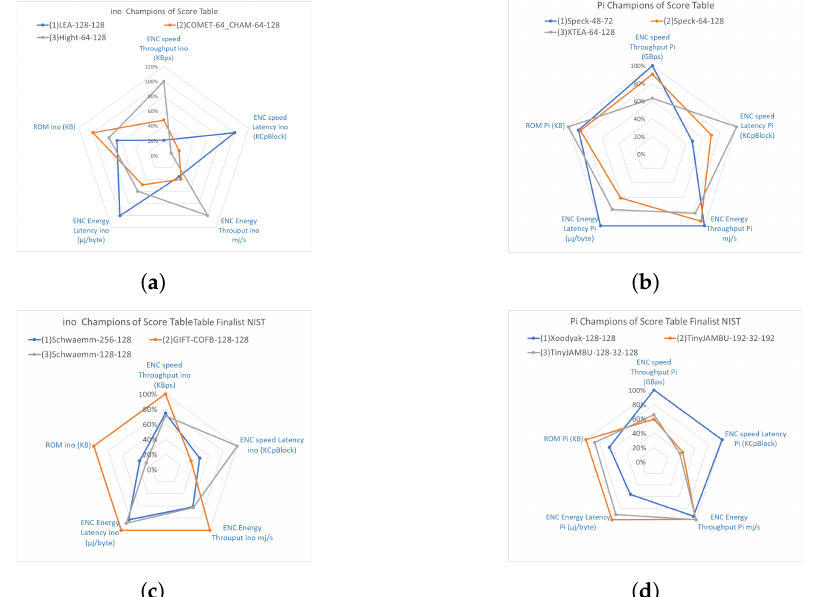
Figure 26. NIST best algorithms in UNO vs. Pi. ( a ) Best 3 For UNO. ( b ) Best 3 For Pi. ( c ) Best 3 for UNO. ( d ) Best 3 for Pi.